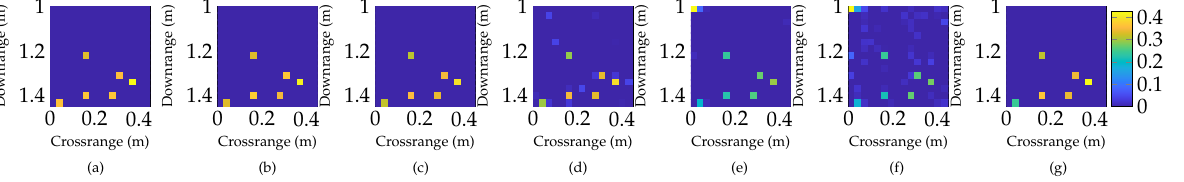
Figure 14. Object recovery for a single case with compression ratio K / MN = 20% with M = N = 30. ( a ) Ground-truth, ( b ) TRPCA-AT(log) (proposed), ( c ) TRPCA-AT(exp) (proposed), ( d ) TRPCA- T, ( e ) LRPSRC, ( f ) URPCA-T, and ( g ) SP with 100% of data. The proposed TRPCA-AT approaches are able to identify all six objects successfully by only utilizing 20% of data compared to the unweighted approach TRPCA-T.